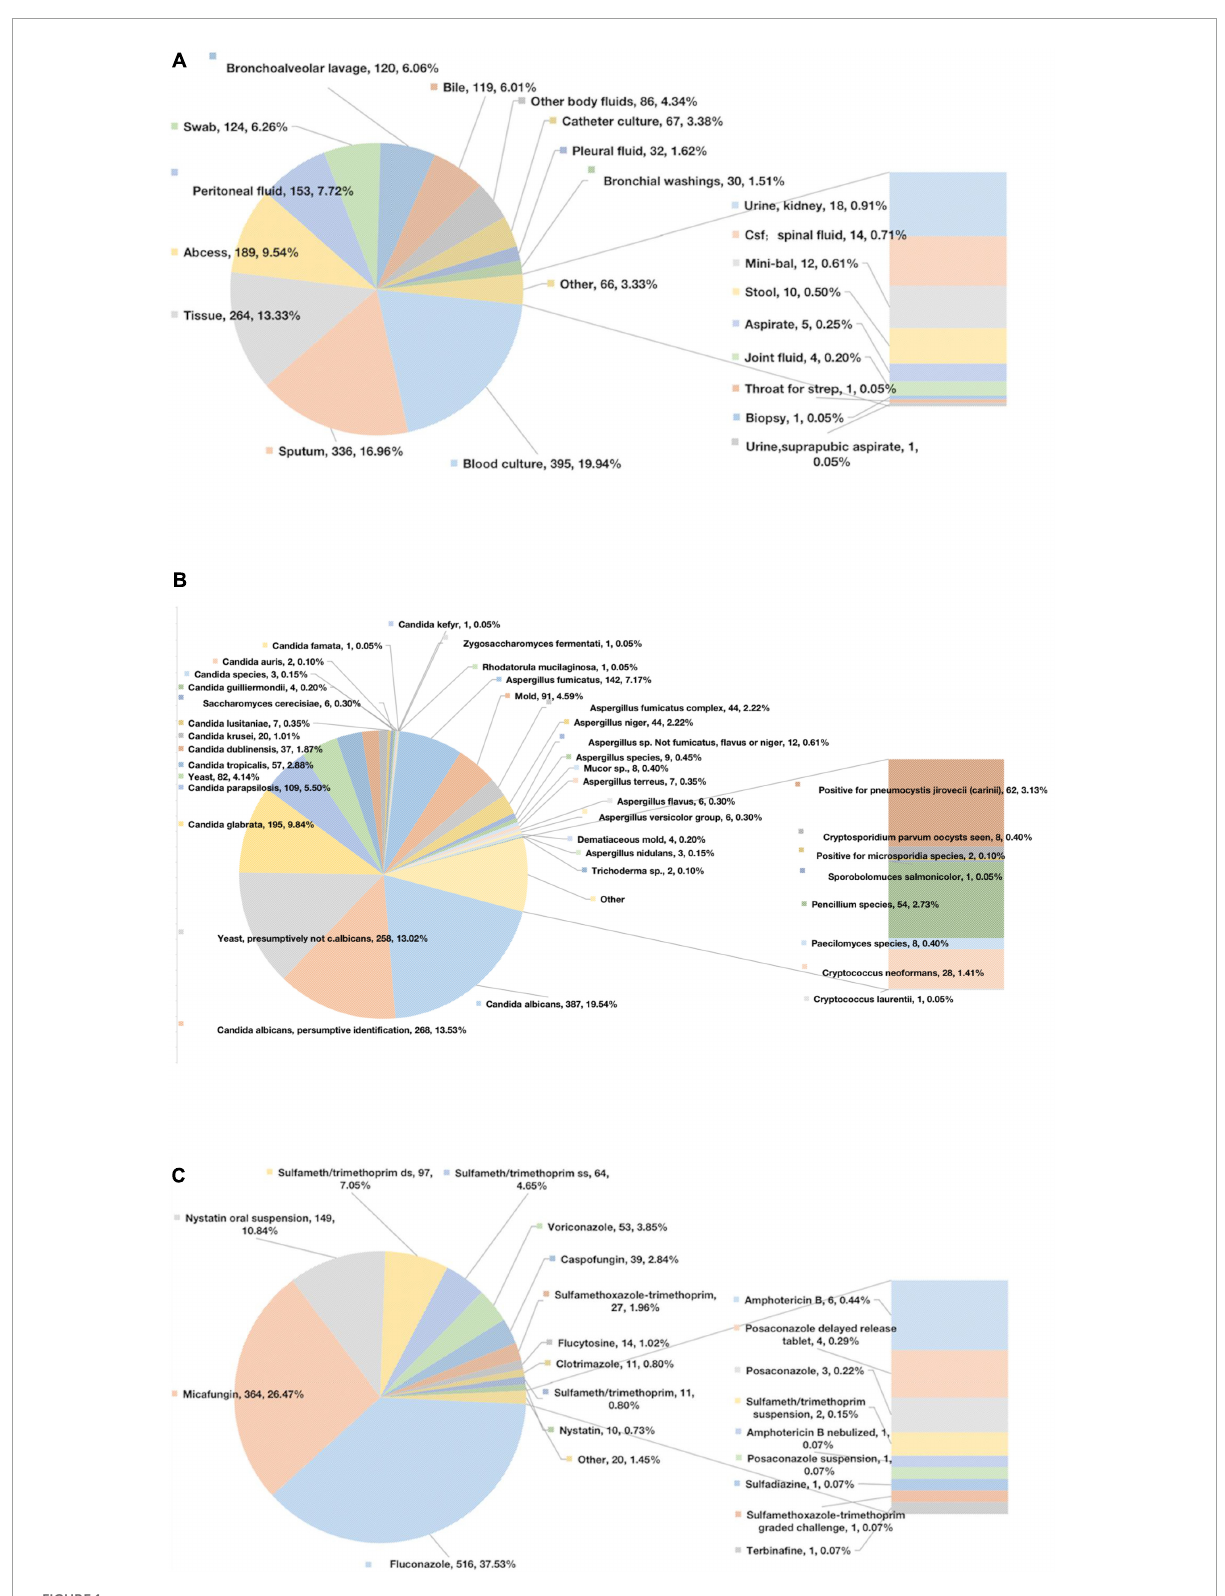
FIGURE1 Microbiological data. (A) The sites of infection of fungus. (B) Specific positive fungal species. (C) Specific antifungal